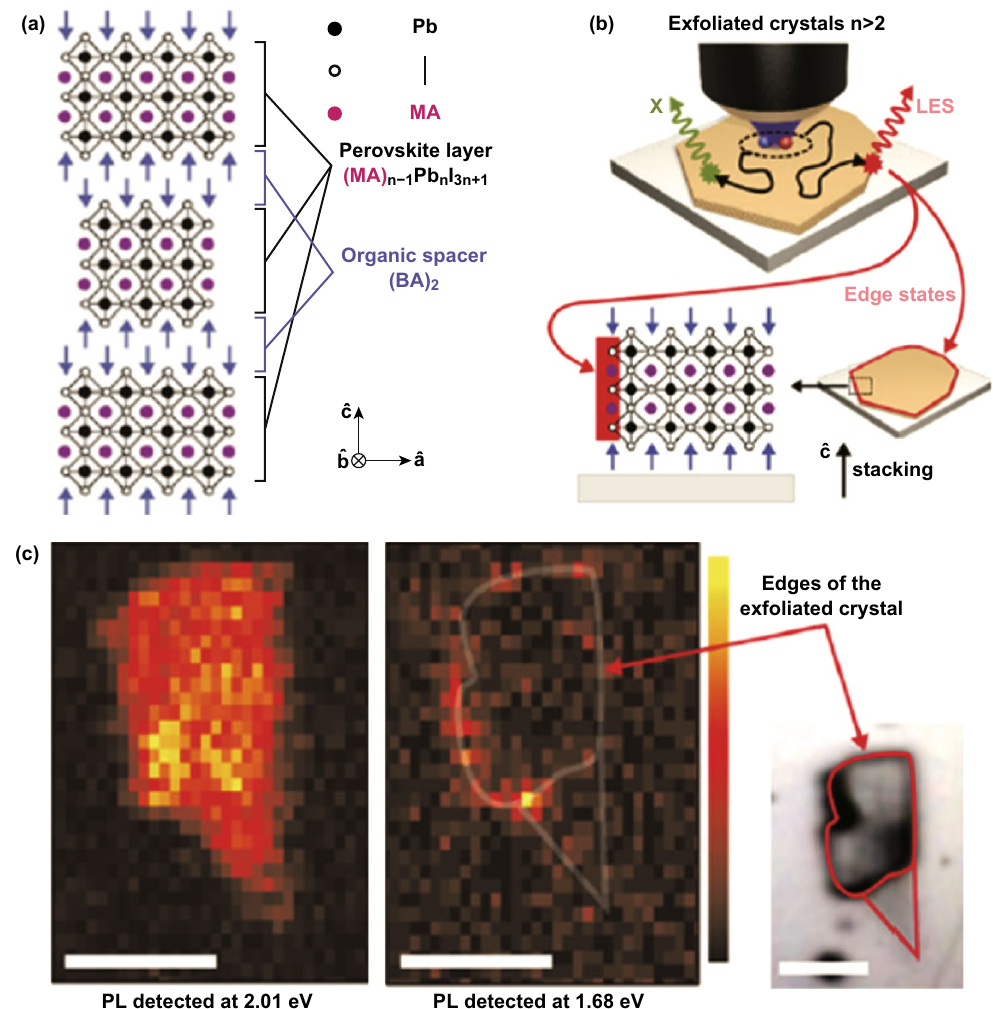
Fig. 8 Edge emission in (BA) 2 (MA) n −1 Pb n I 3 n +1 2D R–P perovskite with n = 3. a Schematics of crystal structure. b Schematics of the photoab- sorption and PL processes in 2D perovskite exfoliated crystals with n > 2. c Photoluminescence intensity map of a single exfoliated crystal. Scale bar is 10 μm. Reprinted with permission from Ref. [10]. Copyright American Association for the Advancement of